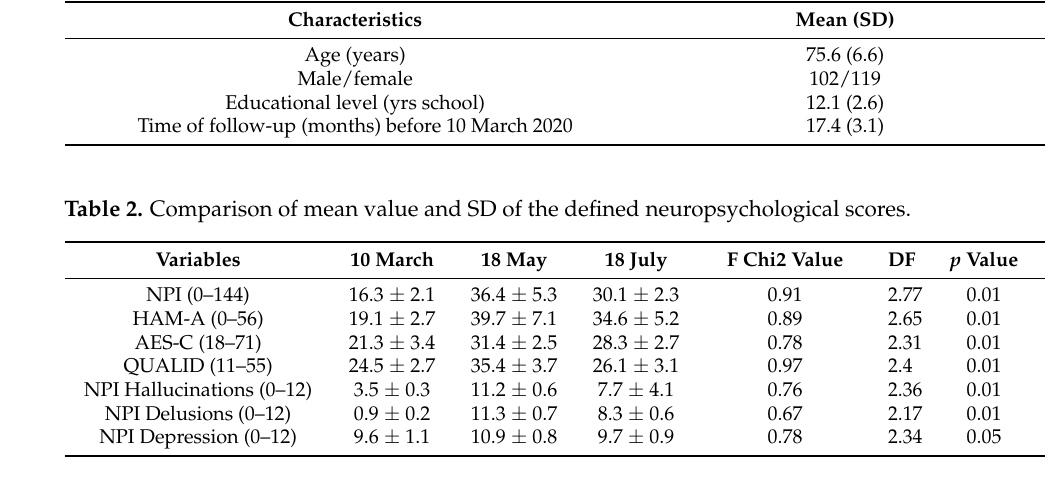
Table 1. Baseline characteristics of the population before the lock-down period.